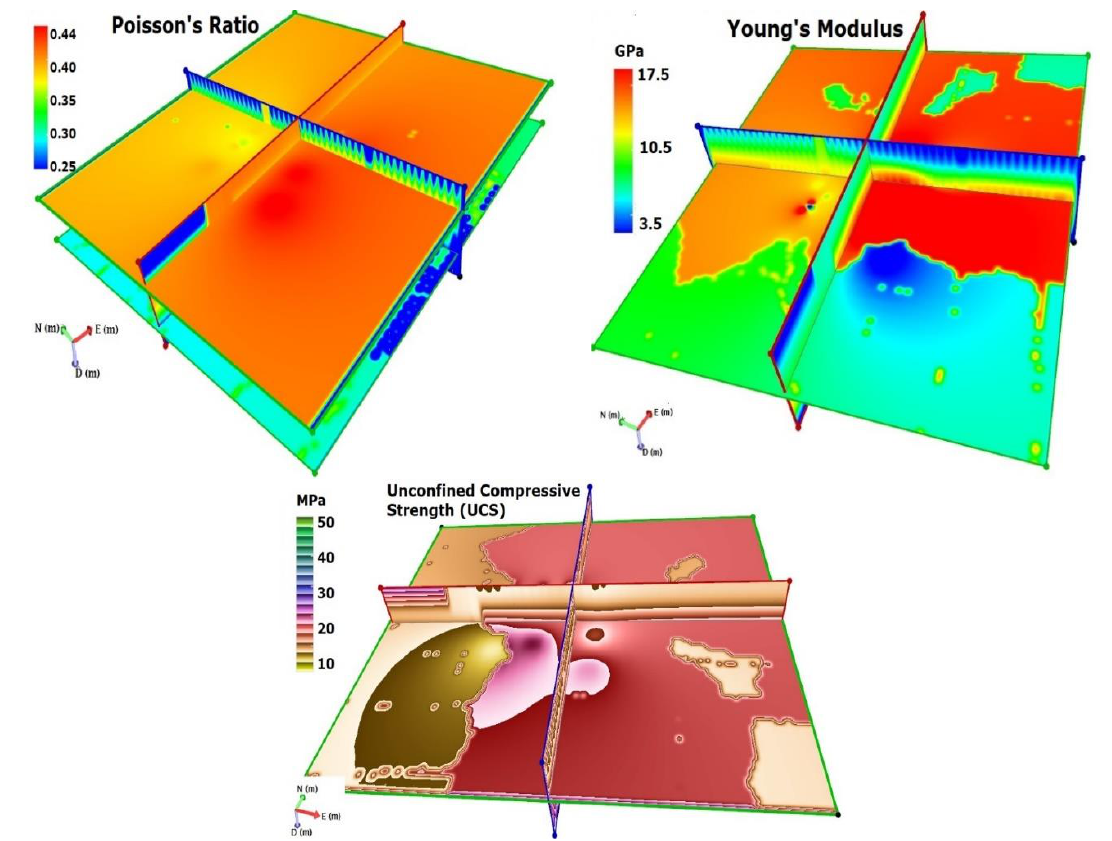
Figure 13. Depth slice view of 3D spatially distributed elastic moduli and rock strength